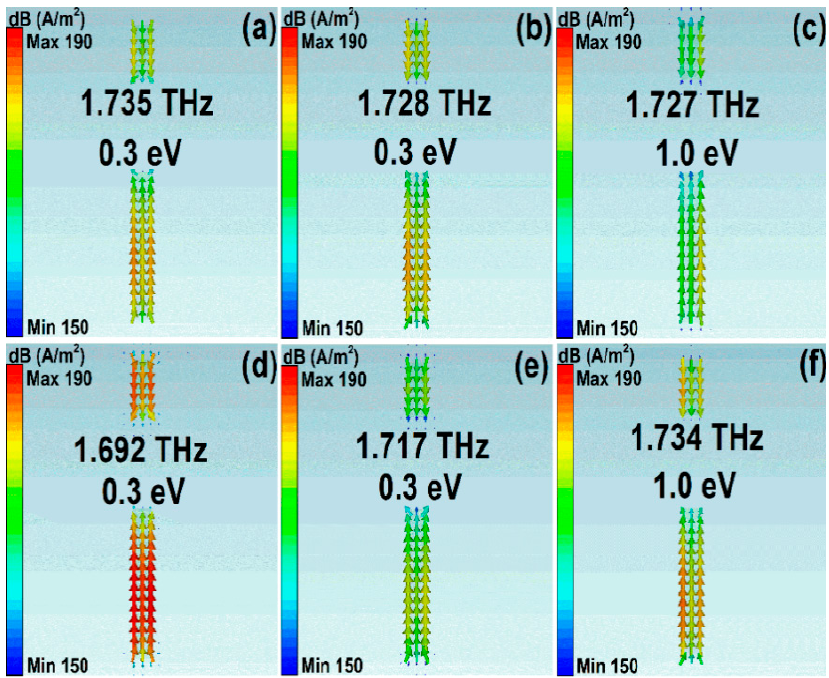
Figure 9. The surface current density for the asymmetrical graphene stripe patters structures at different Fermi levels. ( a–c ) The simulation results for Model II. ( d–f ) The simulation results for Model II on condition that the phonon scattering was included. The polarization direction of incident light was along the y direction. The graphene Fermi levels were 0.3, 0.5, and 1.0 eV, respectively.